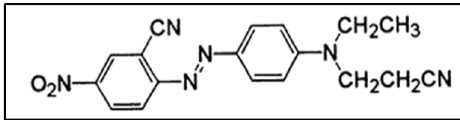
Figure 1. Chemical structure of Disperse Red 73 (DR73).